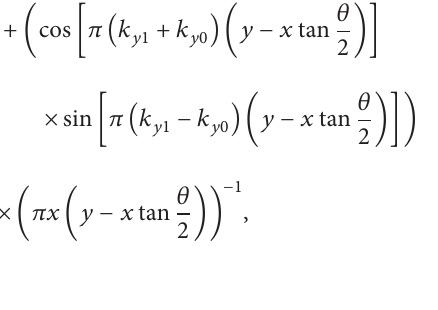
spectrum is often not continuous due to incomplete